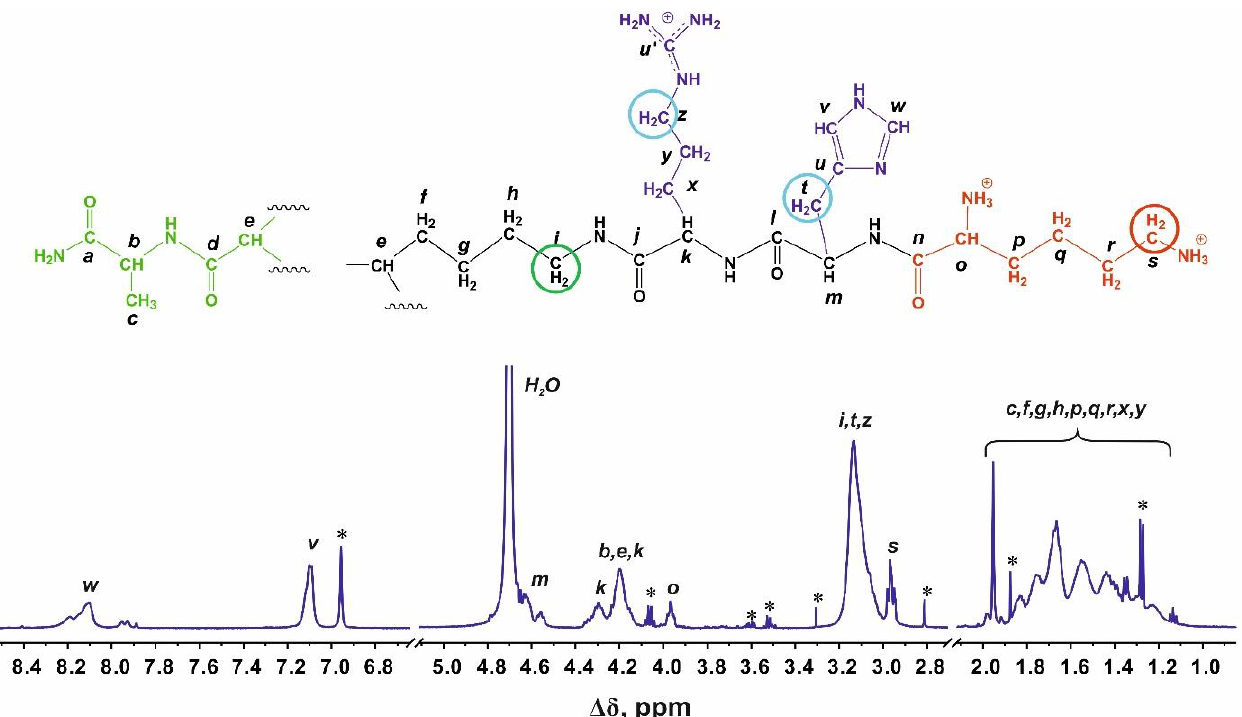
Figure 1. 1 H NMR spectrum of the Lys-Arg-His dendrimer at 298 K. The dendrimer contains three types of methylene groups connected with nitrogen atoms (or imidazole rings in His residues), which have been used in NMR relaxation study: inner groups (green open circle), side groups (blue circles) and terminal groups (red circle). The peaks from small molecular weight impurities are marked by asterix (*).